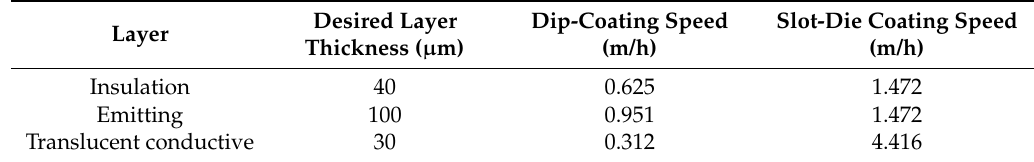
Table 2. Comparison of coating method withdrawal speed for layers in ACPEL structure. Desired Layer